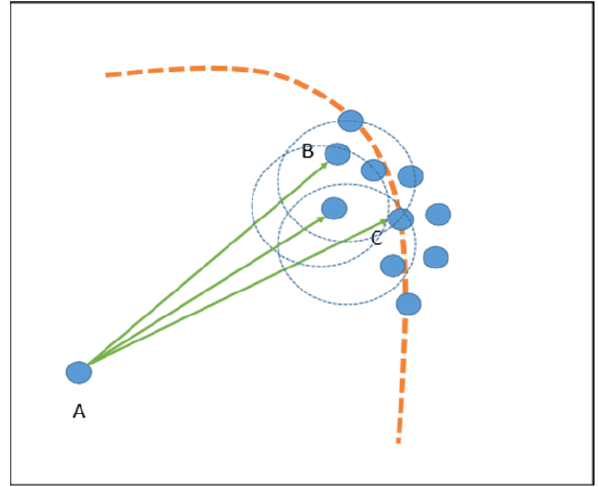
Figure 6. k th nearest neighbors for point A , k = 3.